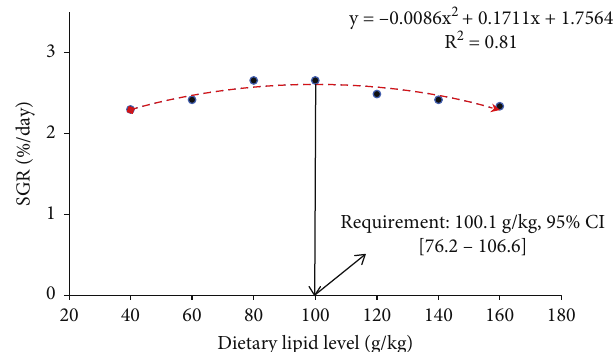
= 55 : 62 , p = < 0 : 001 , con fi dence 6,14